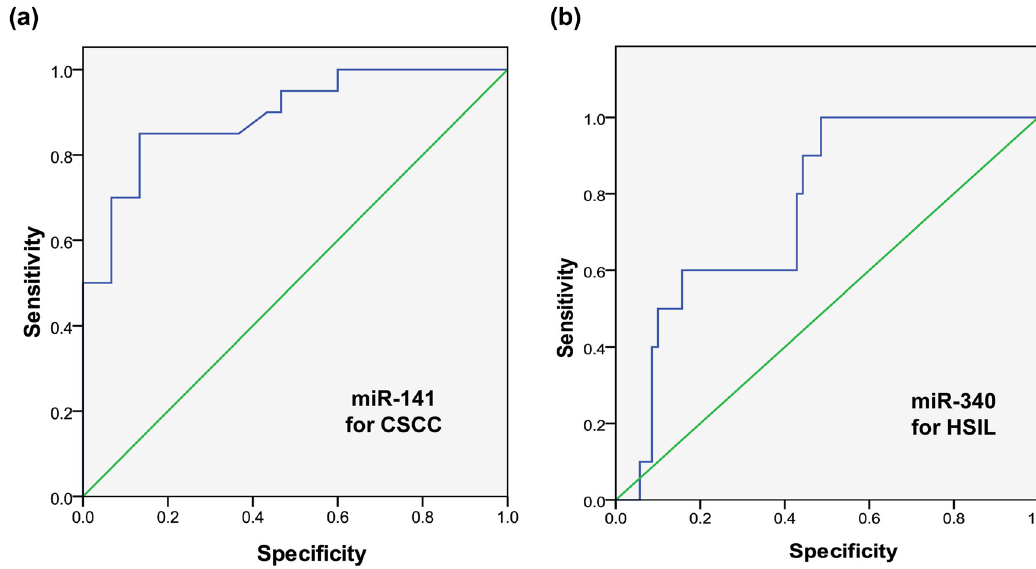
Figure 1: ROC curves of miR - 141 for CSCC diagnosis ( a ) and miR - 340 for HSIL diagnosis ( b )